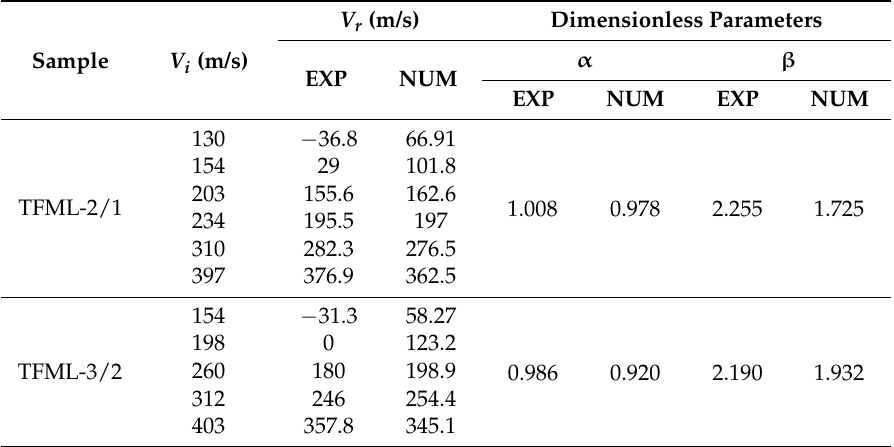
Figure 3. Variation of the projectile residual velocity for different impact velocity. ( a ) TFML-2/1 panel; ( b ) TFML-3/2. Table 4. Impact velocity and corresponding residual velocity